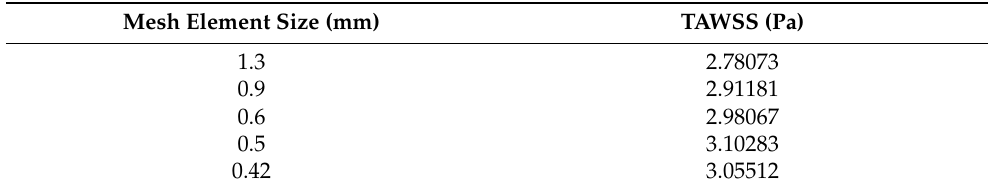
Table 1. Maximum TAWSS values at the third numeric cycle for different mesh size.